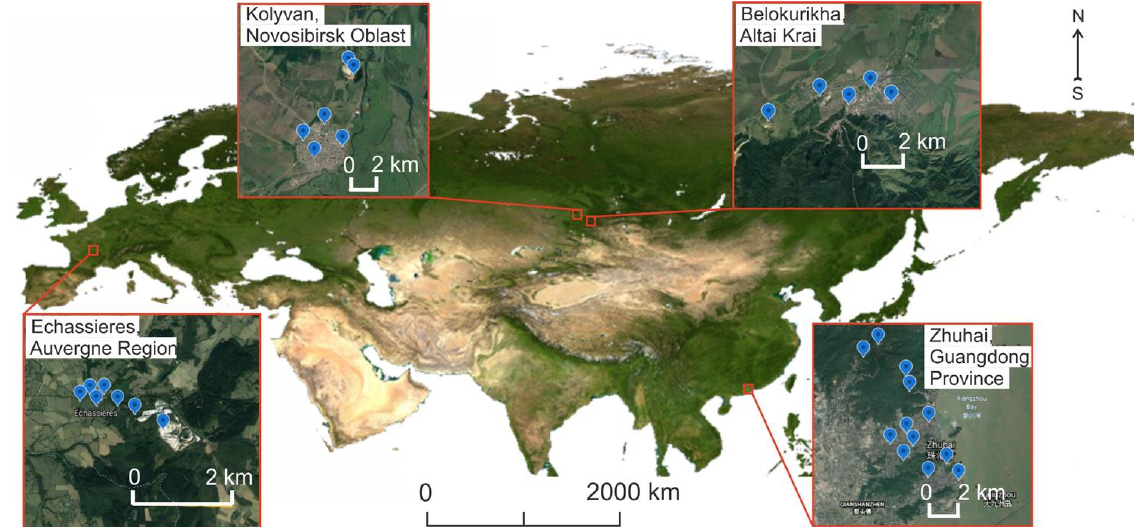
Figure 1. Study areas identified with city names and sampling sites (symbols) The activity concentrations of radon in surface air, or radon volume activity (RVA) measurements were made using the equipment “ Alfarad ” RRA-01M-01. The principle of device operation is based on the electrical deposition of 218 Po ( 222 Rn decay product) on the surface of a silicon detector and measurement of the 218 Po alpha radiation. The radon flux density (RFD), i.e., the 222 Rn transfer rate per unit area from the ground to the atmosphere, was determined as a measure of the Rn source strength. The determinations of RVA (Bq m − 3 ) and RFD (mBq (m 2 s) −1 ) were based on certified reference methods [43]. The radio- metric methods and guidelines followed are compatible with ISO 11665-11:2016 [44]. The detection limit for RVA in the air was 1 Bq m − 3 . The maximum relative standard error of RVA determinations was 20%.